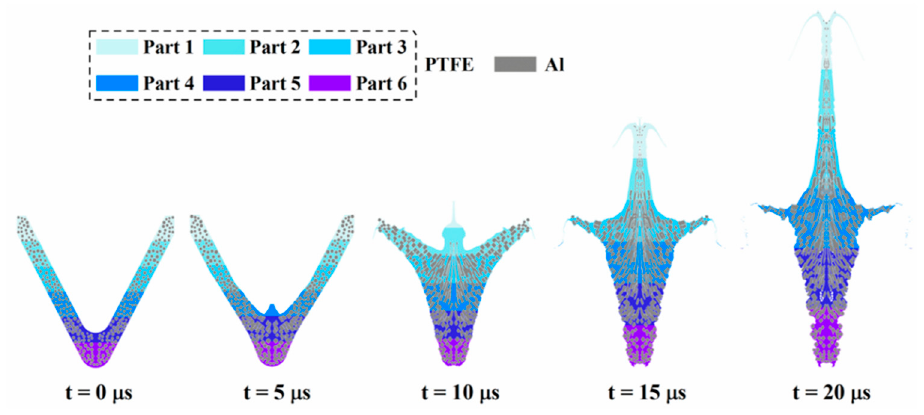
Figure 8. Formation of typical reactive material jet.